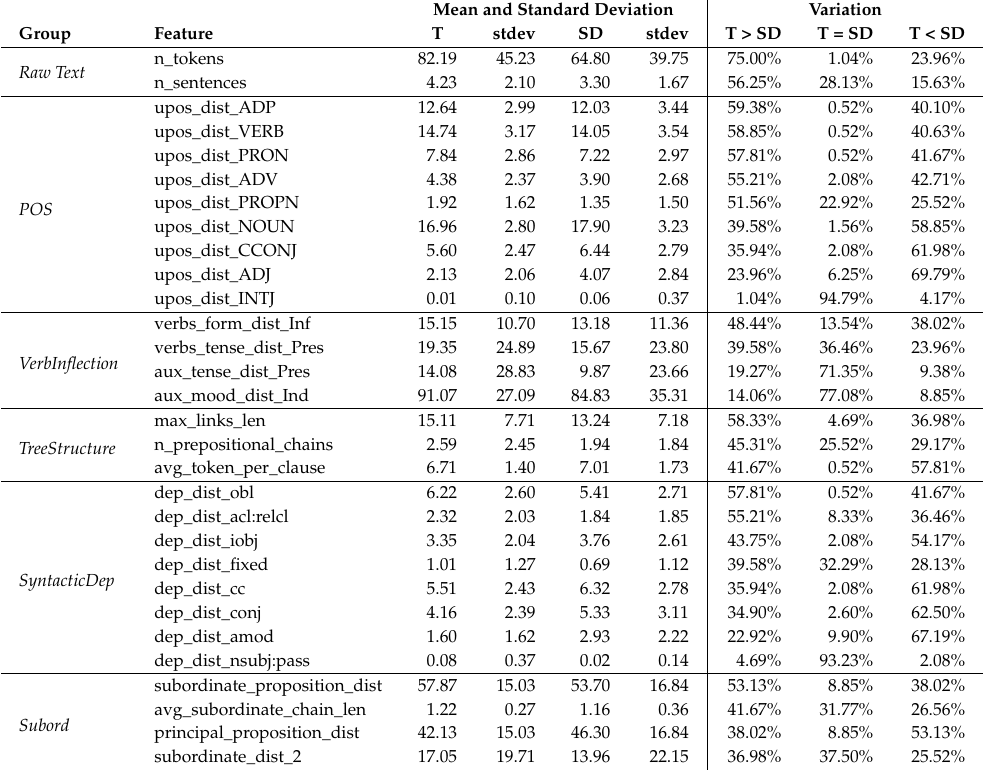
Table 5. Mean features values in Truth (T) and Simulated Deception (SD) testimonies and their standard deviations (stdev). The “Variation” block reports the percentage of testimonies where the feature value was higher (T > SD), equal (T = SD), or lower (T < SD) in truth than in simulated deception